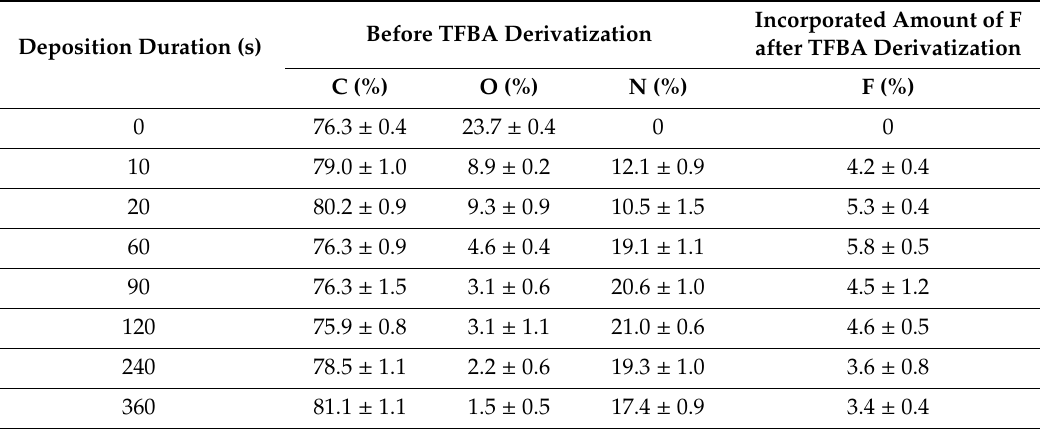
Table 1. Elemental composition of untreated and PPF-NFs for di ff erent deposition durations and percentage of incorporated F after TFBA